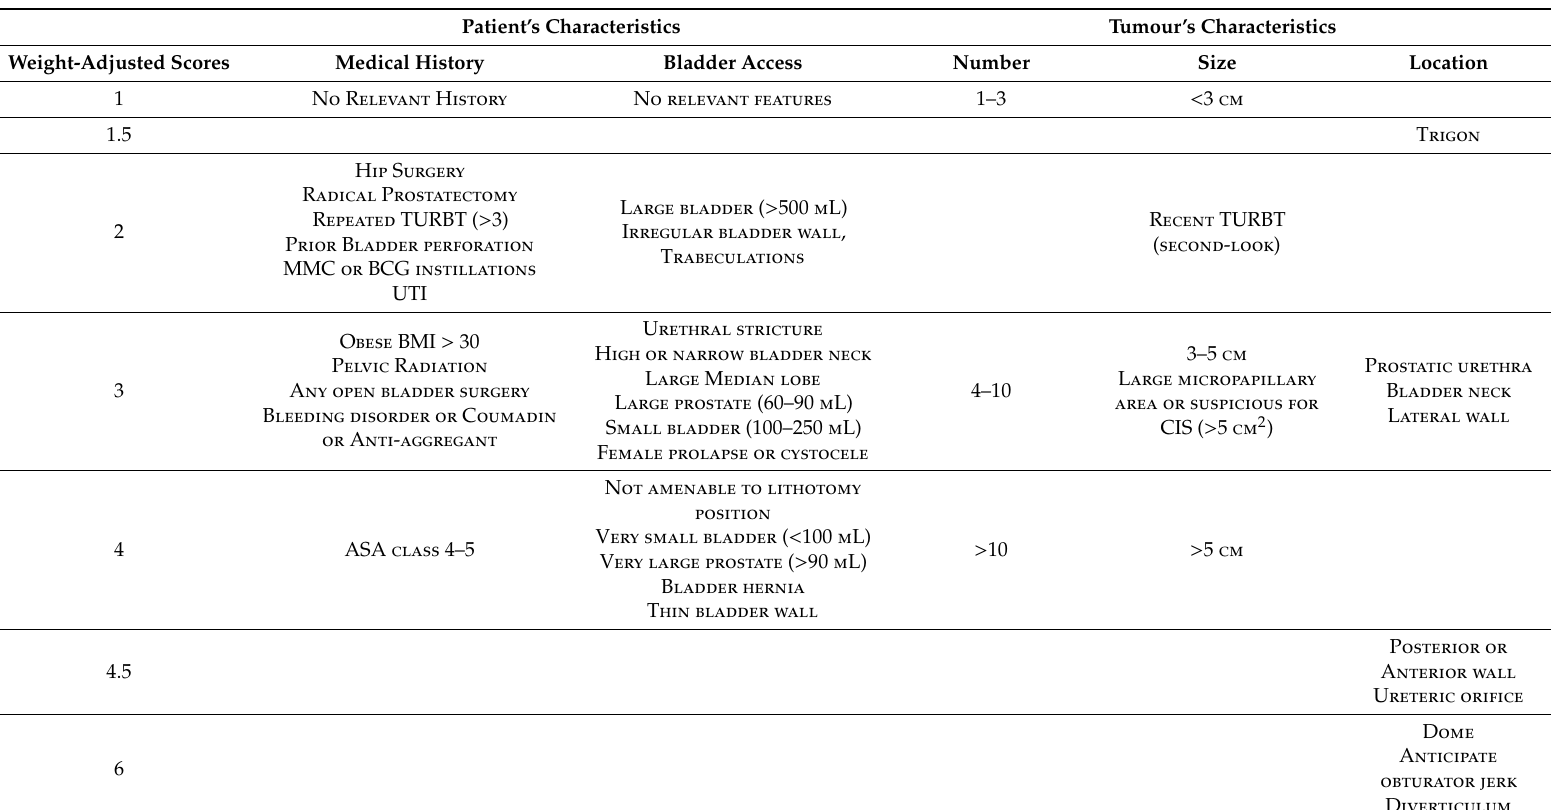
Table 3. Checklist detailing the five domains related to the prediction of a complex transurethral resection of bladder tumours by the panel. The Bladder Complexity Score (BCS) was calculated as the sum of the weight-adjusted scores. Increments in BCS relate to the positive and negative predictive values of experiencing a complex surgery, that is, “any TURBT / En-bloc dissection that results in incomplete resection and / or prolonged surgery ( > 1 h) and / or significant (Clavien-Dindo ≥ 3) perioperative